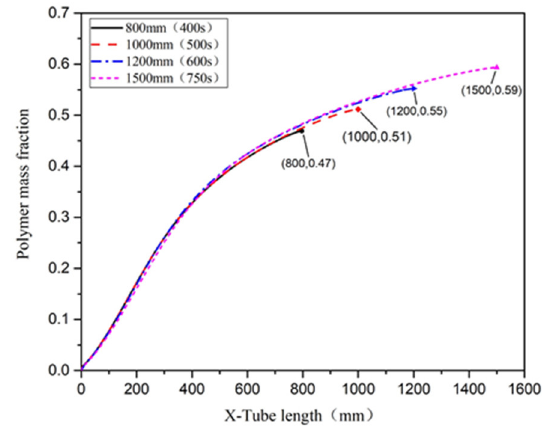
Figure 24. Polymer conversion of styrene in a microreactor at different residence times. Processes 2020 , 8 , x FOR PEER REVIEW